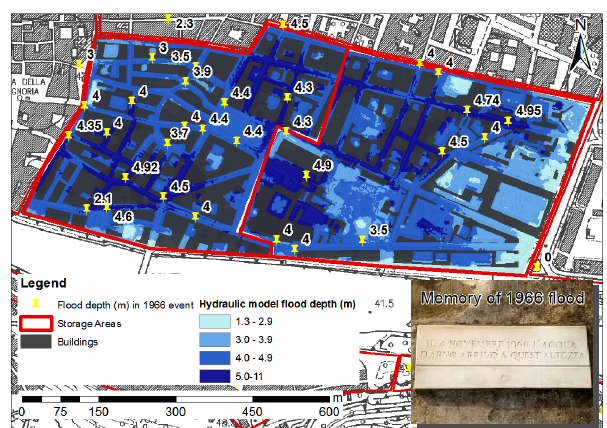
Figure 7. Spatial detail for the S. Croce district of the flood depth estimated for the 200 year 2 Fig. 7. Spatial detail for the St. Croce district of the flood depth event (shades of blue) and maximum water depth from the 1966 event historical plates 3 estimated for the 200yr event (shades of blue) and maximum water (figures). An example picture of such plates is given in the inset. 4 depth from the 1966 event historical plates (figures). An example picture of such plates is given in the